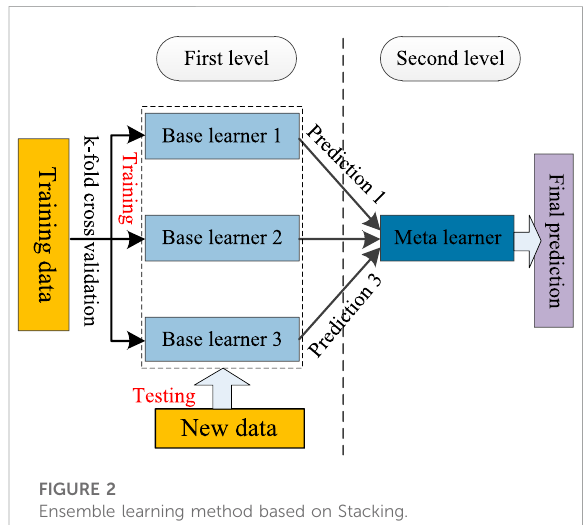
FIGURE 2 Ensemble learning method based on